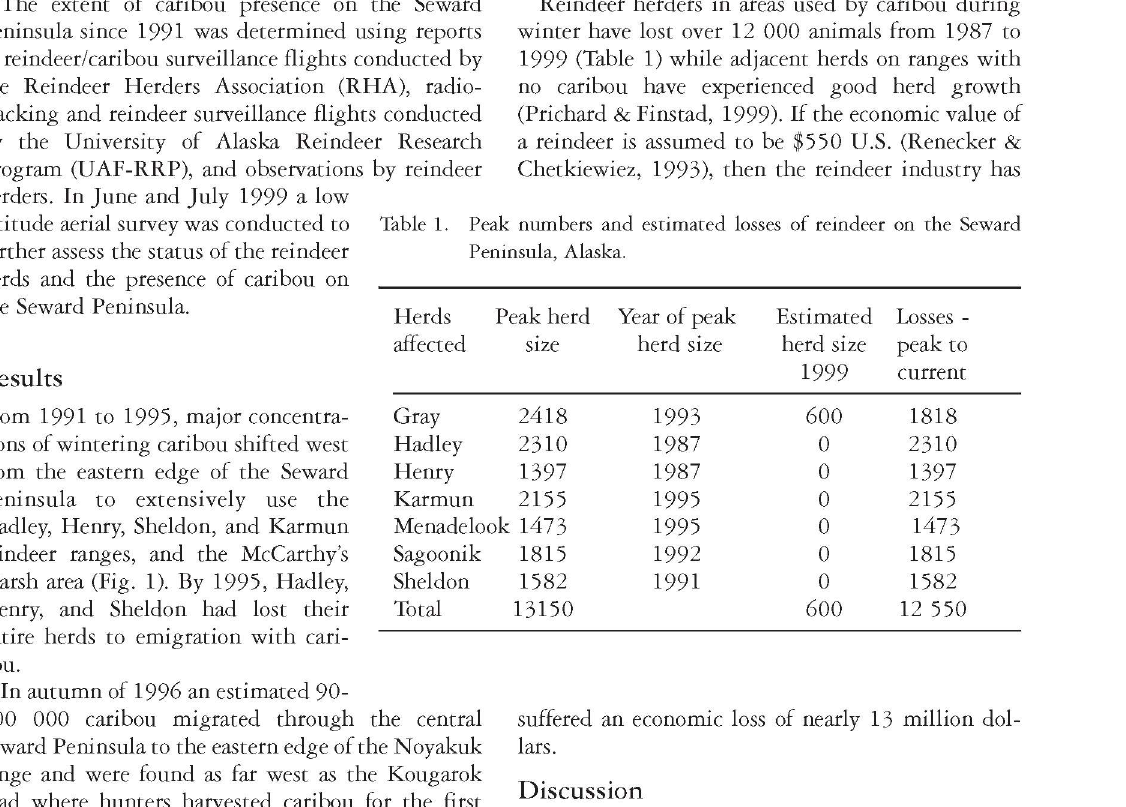
Table 1. Peak numbers and estimated losses of reindeer on the Seward Peninsula,